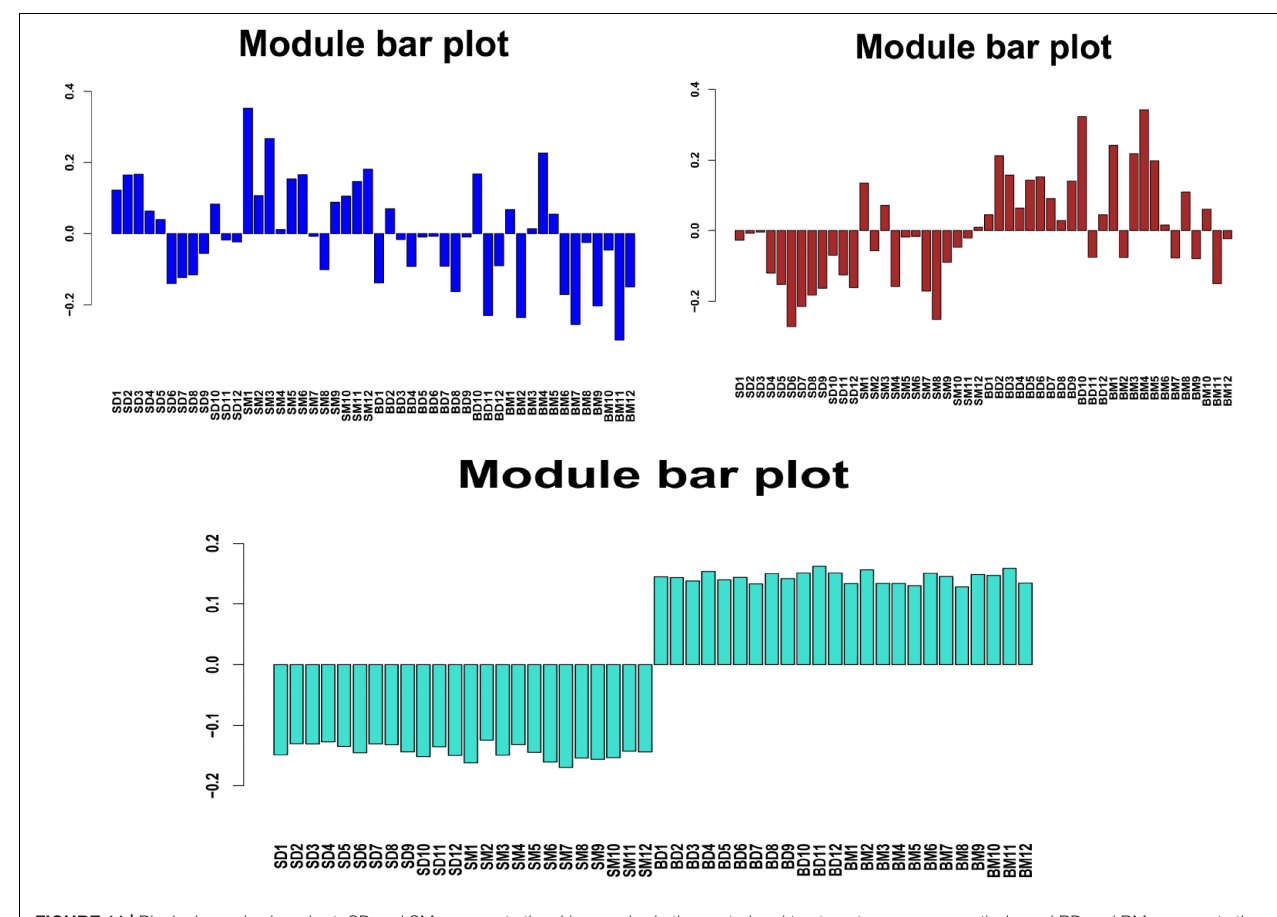
FIGURE 11 | Block eigenvalue bar chart. SD and SM represents the skin samples in the control and treatment groups, respectively, and BD and BM represents the blood samples in the control and treatment groups, respectively.